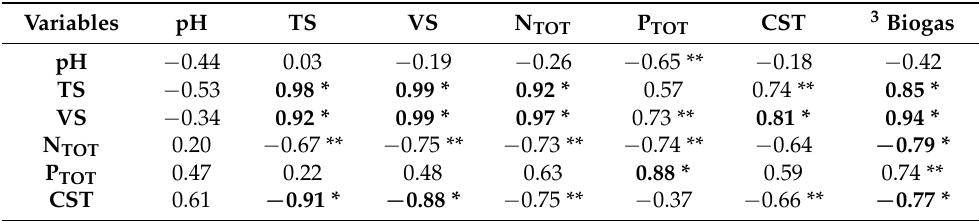
Table A5. Pearson’s correlation coefficients for the technological effects of WAS ultrasonic disintegration (inoculum + WAS_A).